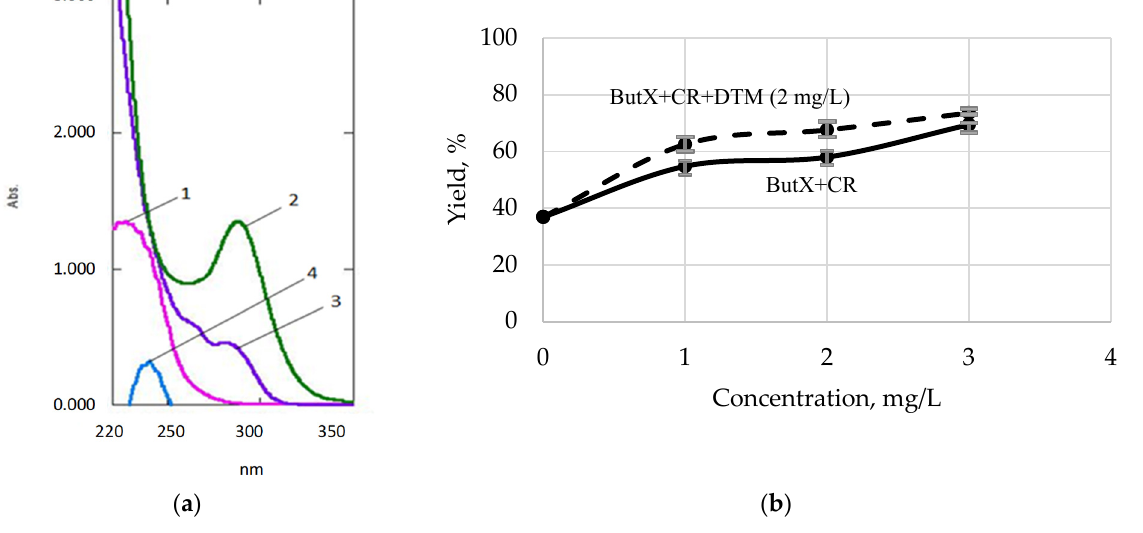
Figure 7. UV spectra of reagent solutions: NH 4 ReO 4 (100 mg/L)—1, DTM (50 mg/L)—2, DTM (50 mg/L) with NH 4 ReO 4 (100 mg/L)—3, DTM with NH 4 ReO 4 relative to DTM solution—4—( a ); results of comparative monomineral molybdenite flotation by ButX + CR 1:1 (solid line) and ButX + CR (1:1) and dithiopyrylmethane DTM (const = 2 mg/L) (dashed line)—( b ).